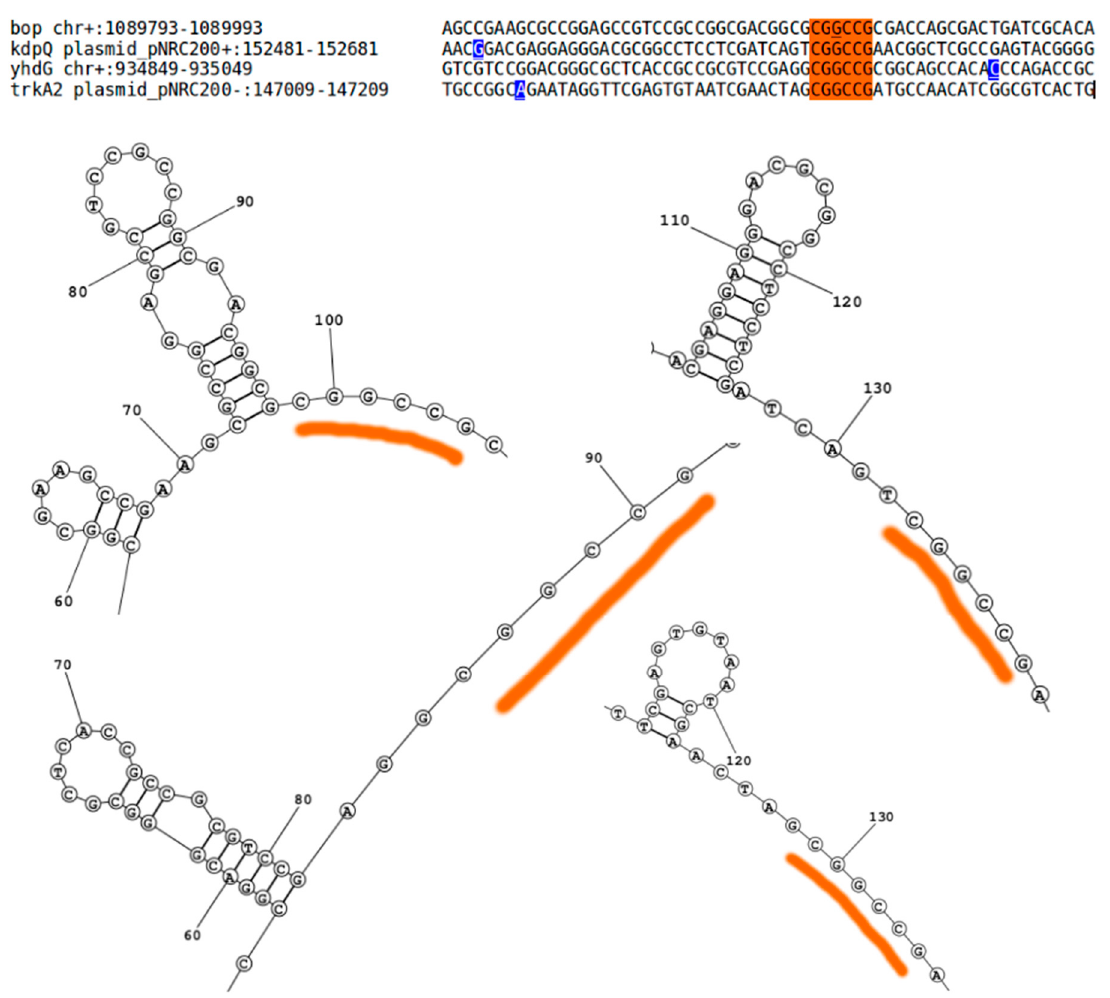
Figure 4. Putative signature found in dysregulated genes after VNG2099C RNase deletion using structure-aware RNA multiple alignment guided by TPS sites. Sequences from − 100 to +100 around TPS (blue underlined bases) inside genes bop , kdpQ , yhdG and trkA2 were used as alignment input. All genes harbor the CGGCCG motif downstream to a strong stem-loop (red highlights). The secondary structure predictions were filtered to report only base pairings with >0.99 probability (zoomed out version in Figure S4). Secondary structure predictions are, from top left to bottom right, for genes: bop , kdpQ , yhdG and trkA2 .